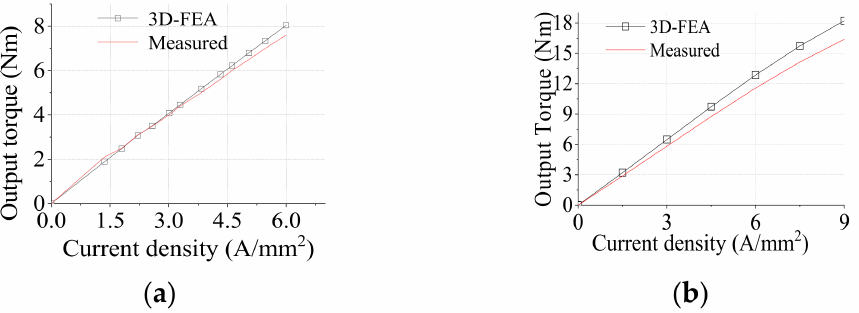
Figure 23. Output torque for two machines with different current densities. ( a ) AMC-FRPM. (b)